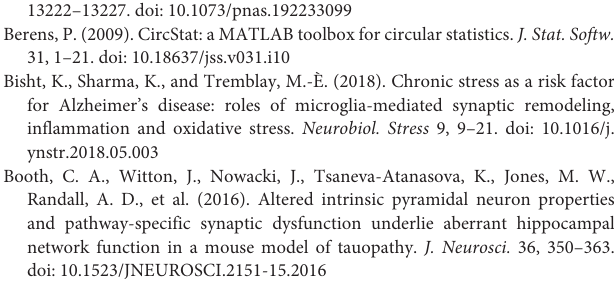
SUPPLEMENTARY FIGURE 1 | The impact of stress on the relationship between CA1 place cell spiking vs. running speed and LFP oscillatory phase. (A) Coronal section of the hippocampus showing the tetrode locations (black arrows) at the CA1 pyramidal layer. (B) Dependence of firing rate on the speed was affected by stress (2-way mixed ANOVA: main effect of speed, F (1,370) = 1,424.752, p < 2.22 × 10 − 16 , main effect of group, F (3,370) = 16.666, p = 3.546 × 10 − 10 ; interaction, F (3,370) = 37.866, p < 2.22 × 10 − 16